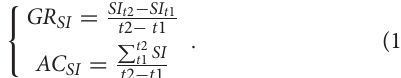
Accumulated curve